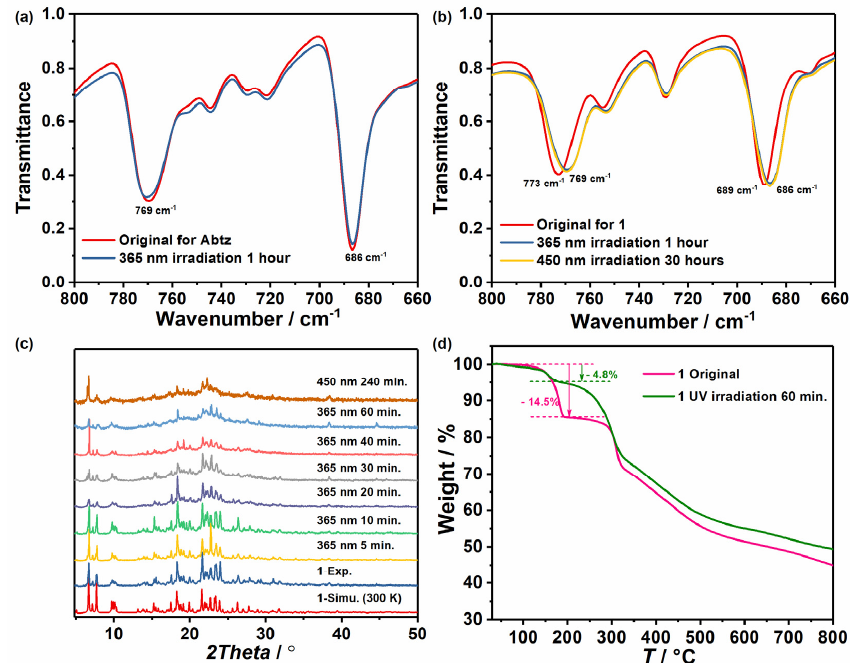
Figure 7. ( a ) IR spectra of Abtz in KBr pellet before and after irradiation with the UV and blue lamp. ( b ) IR spectra of 1 in KBr pellet before and after irradiation with UV lamp. ( c ) PXRD patterns of 1 before and after UV and blue-light irradiation at a different time. ( d ) TG curves of 1 before and after UV irradiation for 1 h. What is more, the IR spectra were maintained unchanged under further blue-light